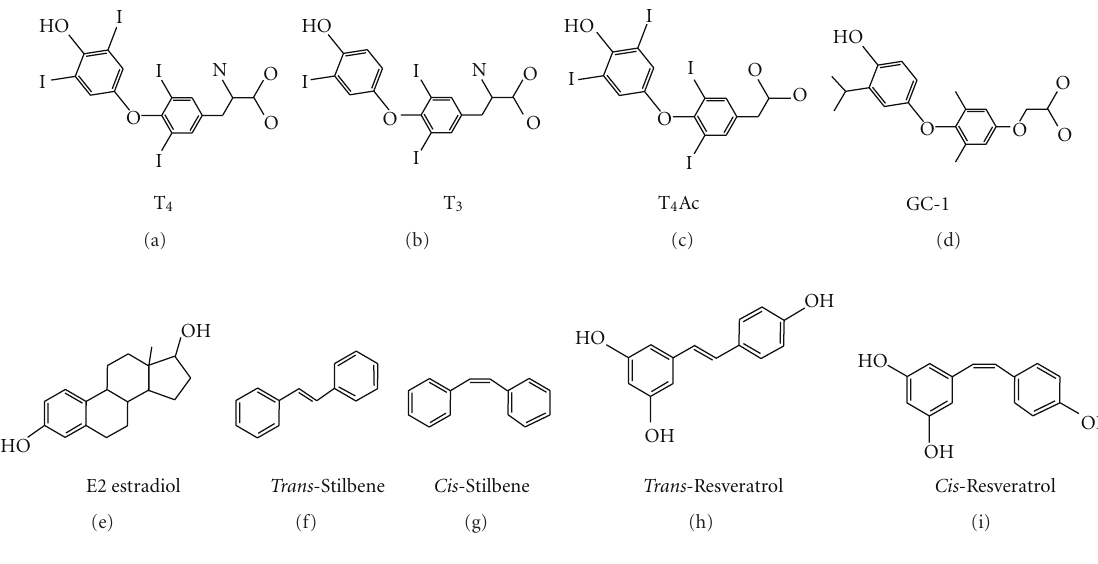
Figure 2: Schematic of ligands bound to α v β 3